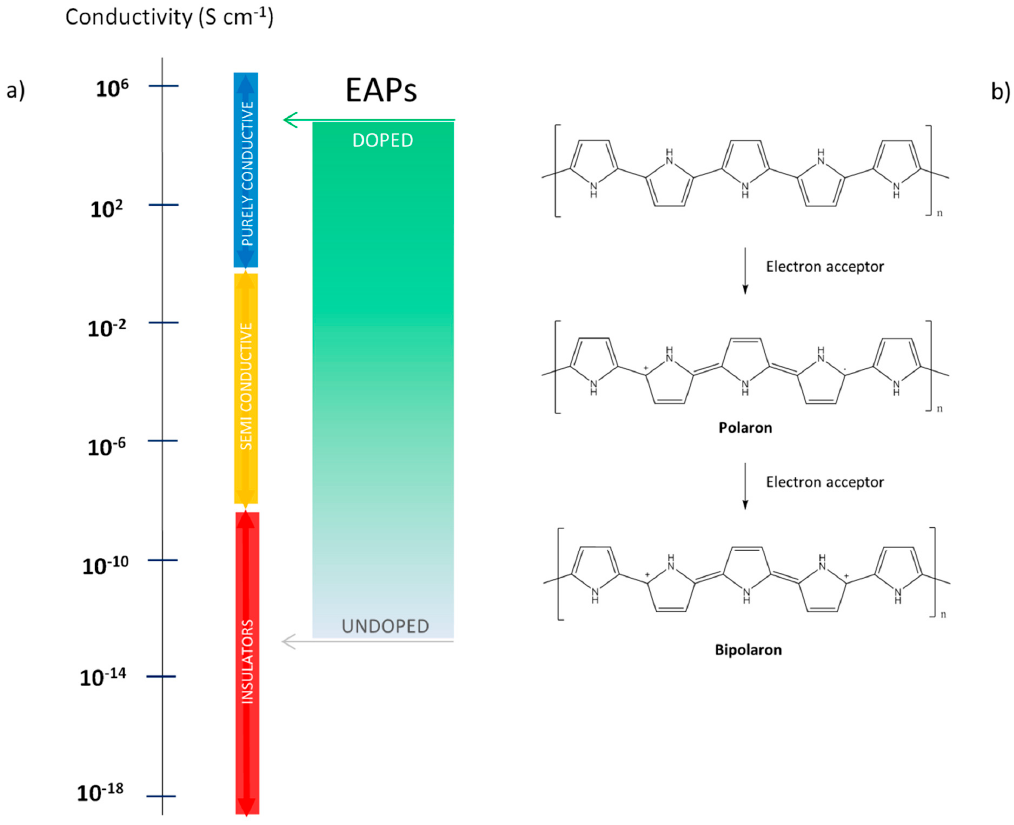
Figure 1. EAP properties: ( a ) Conductivity range of conducting polymers and polymer-based composites (inspired from Kaur et al. , 2015 [8]); ( b ) Polaron and bipolaron formation upon oxidation (p-doping) of polypyrrole.